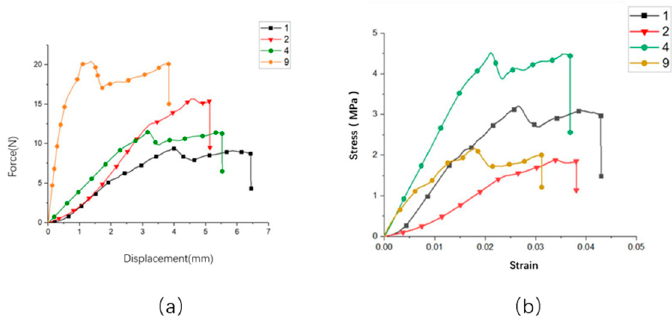
5 of 19 Table 1. Statistical results of hairy vetch steam. Value